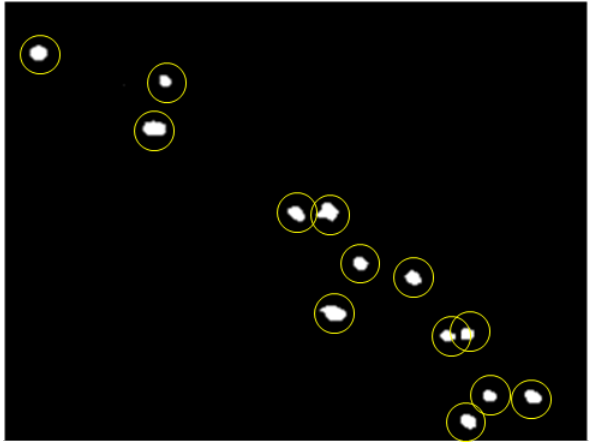
Figure 6: Result of vehicles detected from MS-2